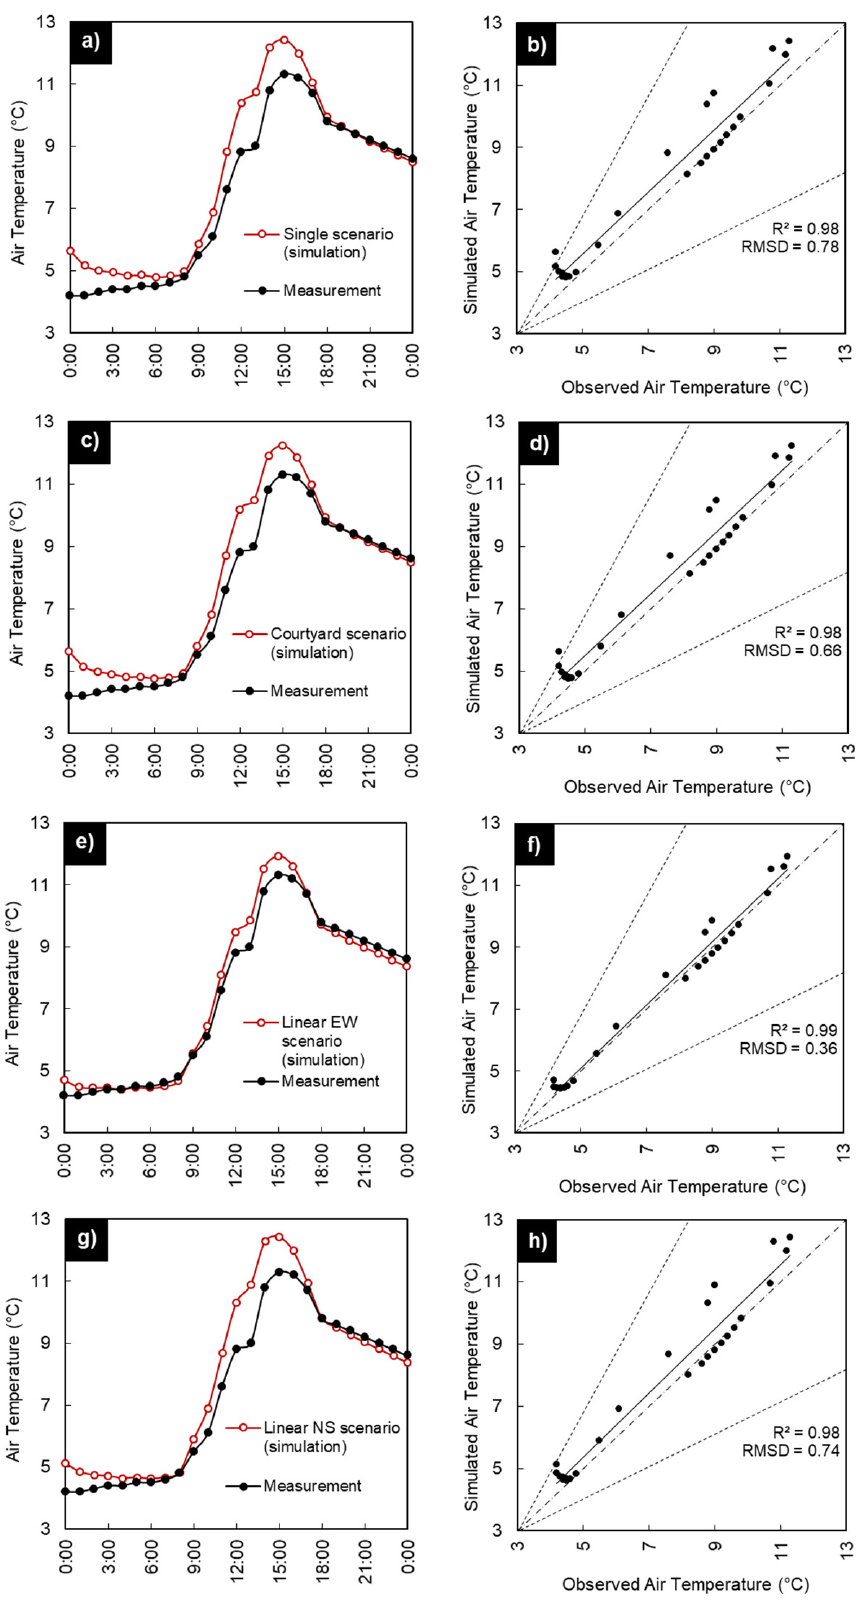
Figure 4. Comparison of measured versus simulated air temperature results in single ( a , b ), courtyard ( c , d ), linear EW ( e , f ), and linear NS ( g , h ) scenarios.